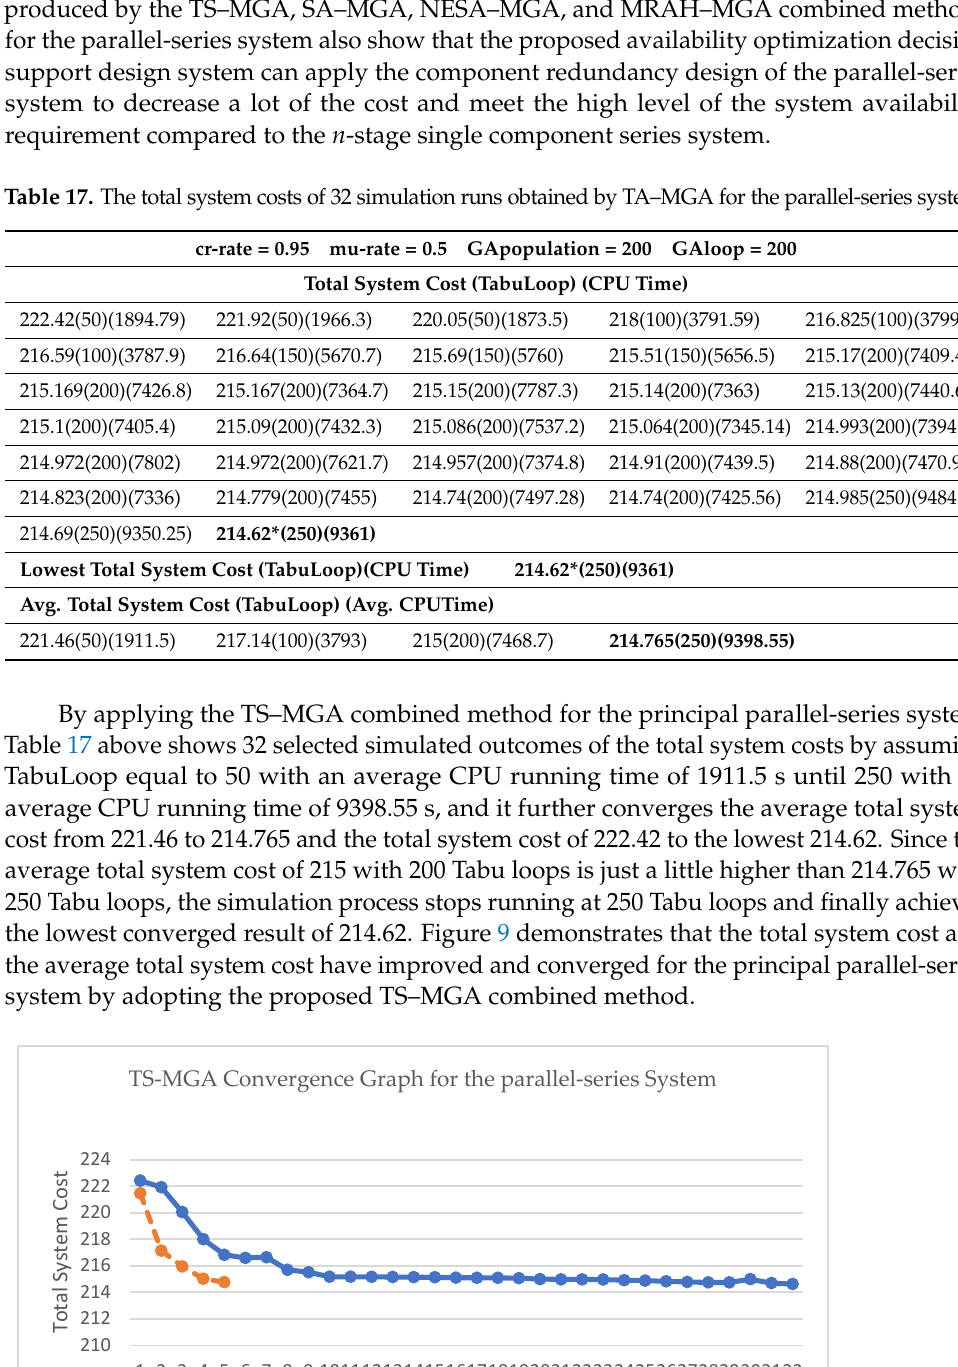
Table 18. Optimal Solutions obtained by TA–MGA for the parallel-series system. TabuLoop = 250 cr-rate = 0.95 mu-rate = 0.5 GApopulation = 200 GAloop = 200 Decision Variables